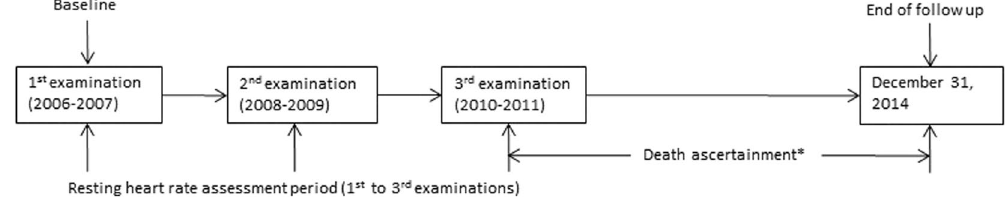
Figure 1. Study design evaluating the association between long term resting heart rate variation and all-cause mortality in the Kailuan Study. Participants were followed up for a median of 49.4